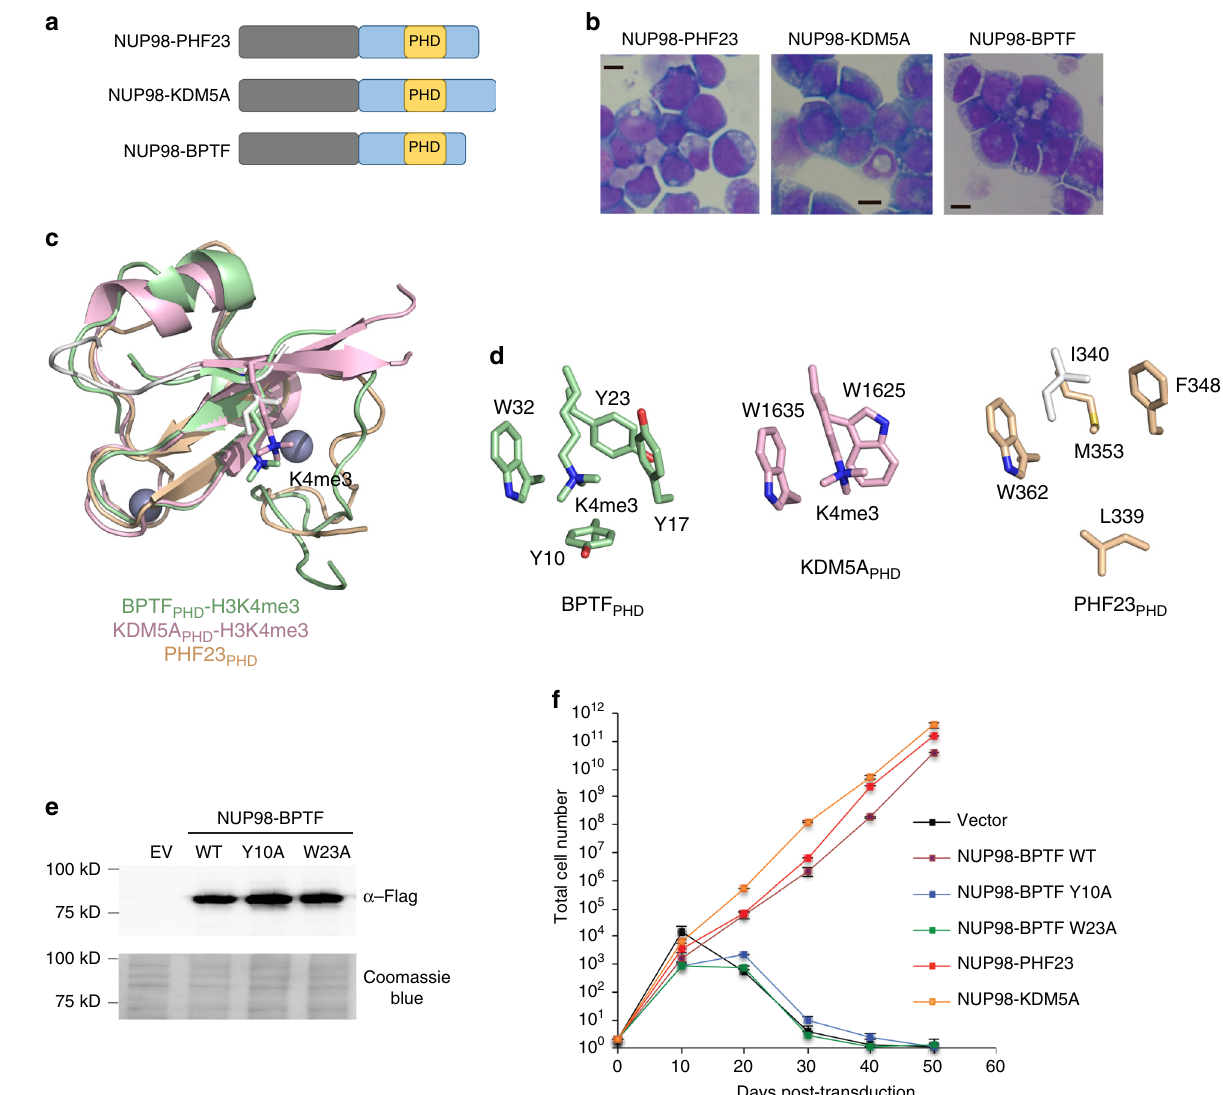
Fig. 5 PHD fi nger-dependent leukemic transformation. a Schematic representation of NUP98 fusion proteins identi fi ed in AML cases. b Wright – Giemsa staining of murine hematopoietic progenitor cells transformed by the indicated NUP98 fusion proteins. Scale bars: 5 μ M. Images were from single experiment. c Superimposed structures of the BPTF PHD (ref. 23 ), KDM5A PHD (ref. 8 ), and PHF23 PHD in complex with indicated ligands. PDB IDs: 2F6J, 3GL6, and 6WXK. The structure of PHF23 PHD superimposes with the structures of KDM5A PHD and BPTF PHD with a RMSD of 0.68 and 1.32 Å, respectively. d A zoom-in view of the aromatic cages of BPTF PHD , KDM5A PHD , and PHF23 PHD . e FLAG immunoblots from single experiment showing protein levels of the indicated FLAG-tagged NUP98 fusion post-transduction into hematopoietic progenitor cells. f Proliferation of the indicated NUP98 fusion post- transduction into hematopoietic progenitor cells. Error represents SD of triplicate measurements, n = 3 biologically independent experiments. Source data are provided in the Source Data fi